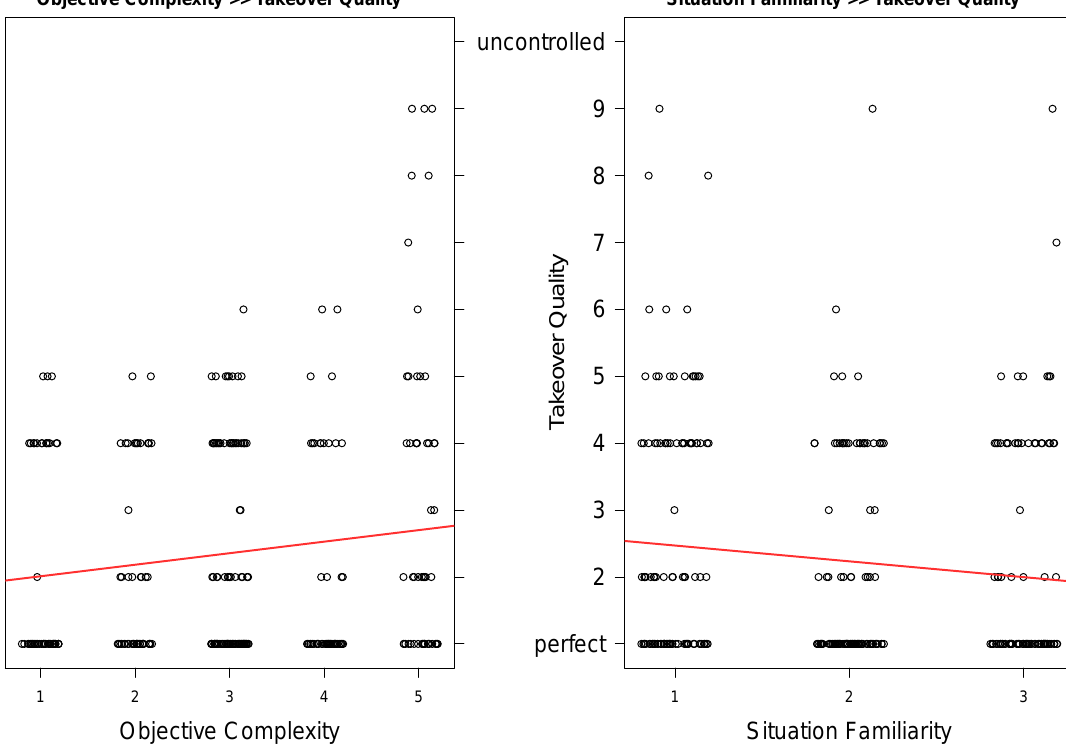
Figure 4. The relation between takeover quality and the objective complexity as relevant vehicles in the surroundingtraffic environment (left ) and between takeover quality and situation familiarity ( right ). Red lines indicate the regression line (significance codes: 0 ‘***’ 0.001 ‘**’ 0.01 ‘*’